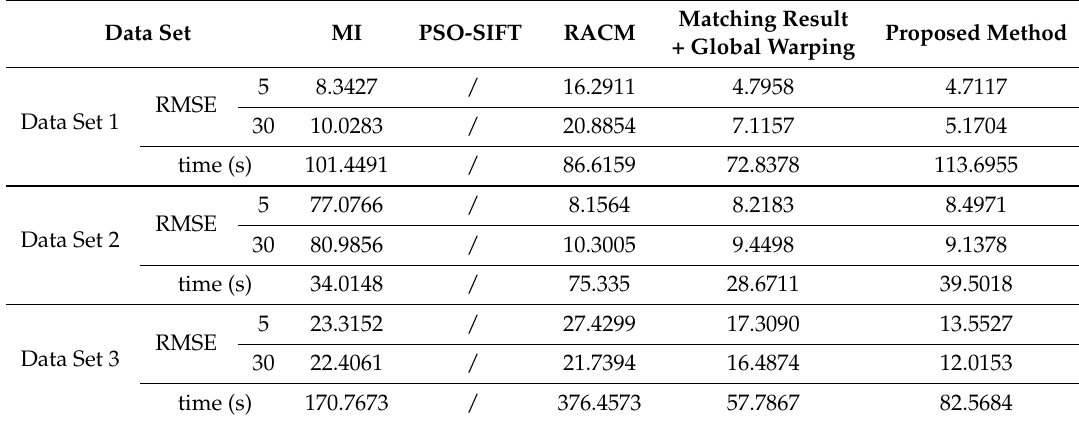
Table 4. Quantitative